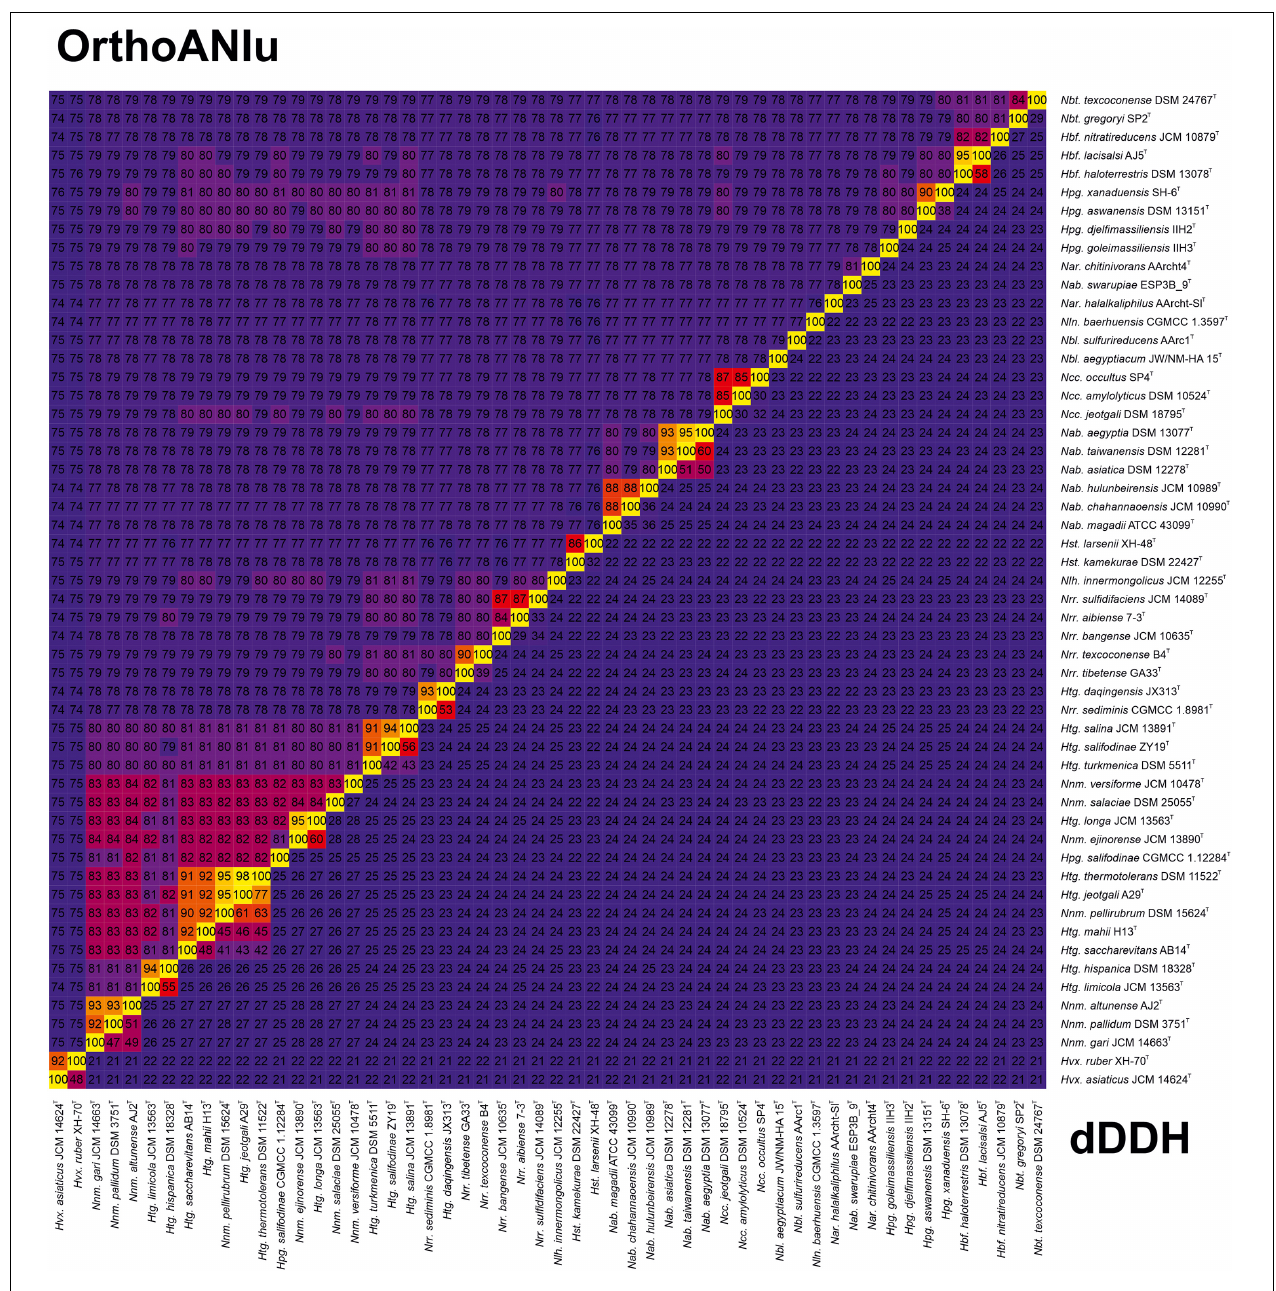
FIGURE 4 | Heatmap of OrthoANIu (upper triangle) and dDDH (lower triangle) relatedness among the type strains of members of the genera Natrinema and Haloterrigen a and representatives of the other genera of the family Natrialbaceae